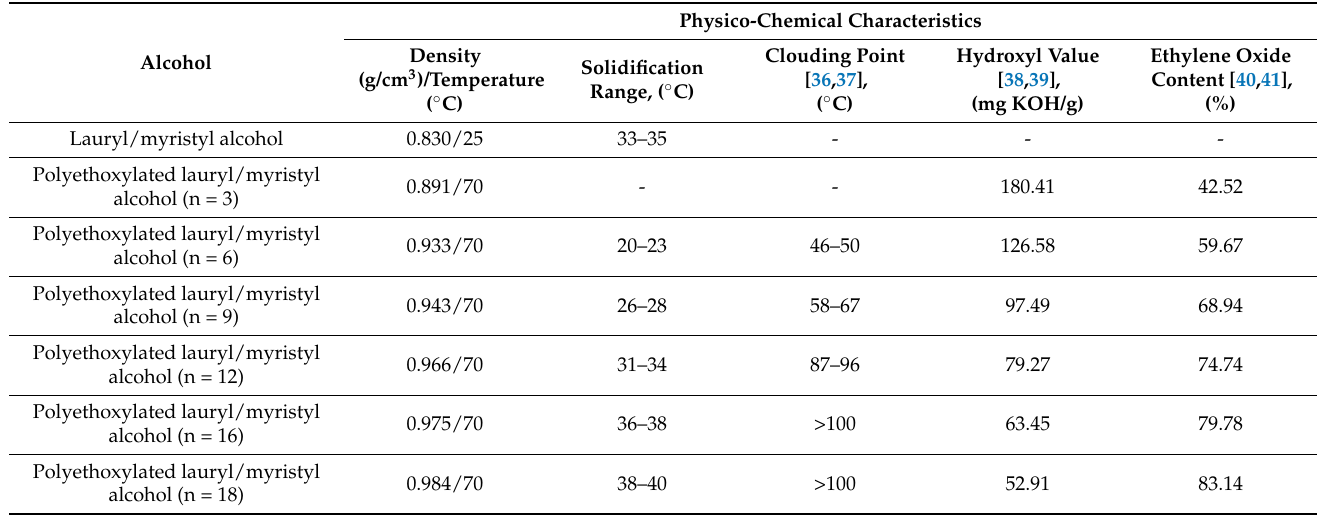
Table 6. The main physico-chemical characteristics of homogeneous lauryl/myristyl 7/3 alcohols as such and homogeneous lauryl/myristyl 7/3 polyethoxylated n = 3, 6, 9, 12, 18 alcohols, LM(EO) n OH, purity 98%.